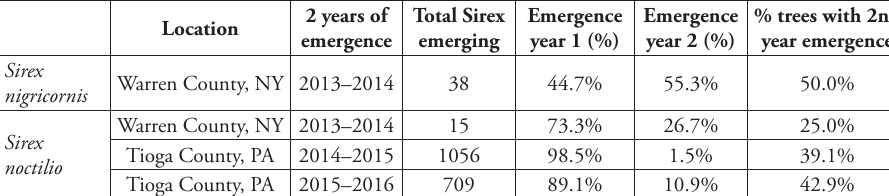
Table 1. First and second year emergence by Sirex noctilio and Sirex nigricornis. Location